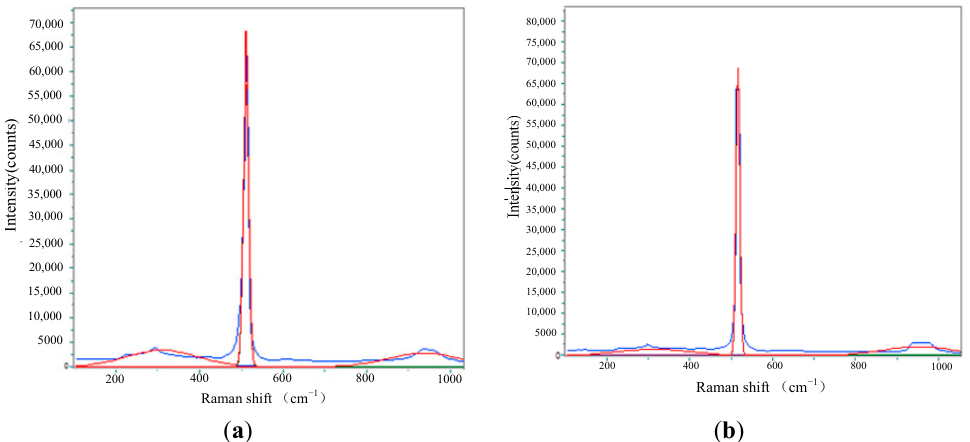
Figure 7. Gaussian peak fitting diagram of Raman spectra of and ordered SiNWs. ( a ) Before annealing. ( b ) After annealing.